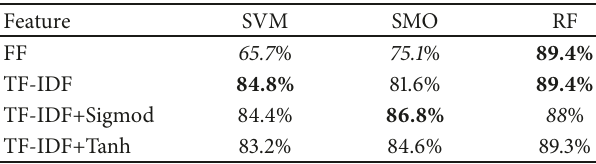
Table 4: Recognition accuracies using three classifiers concerning dataset tulum2009.